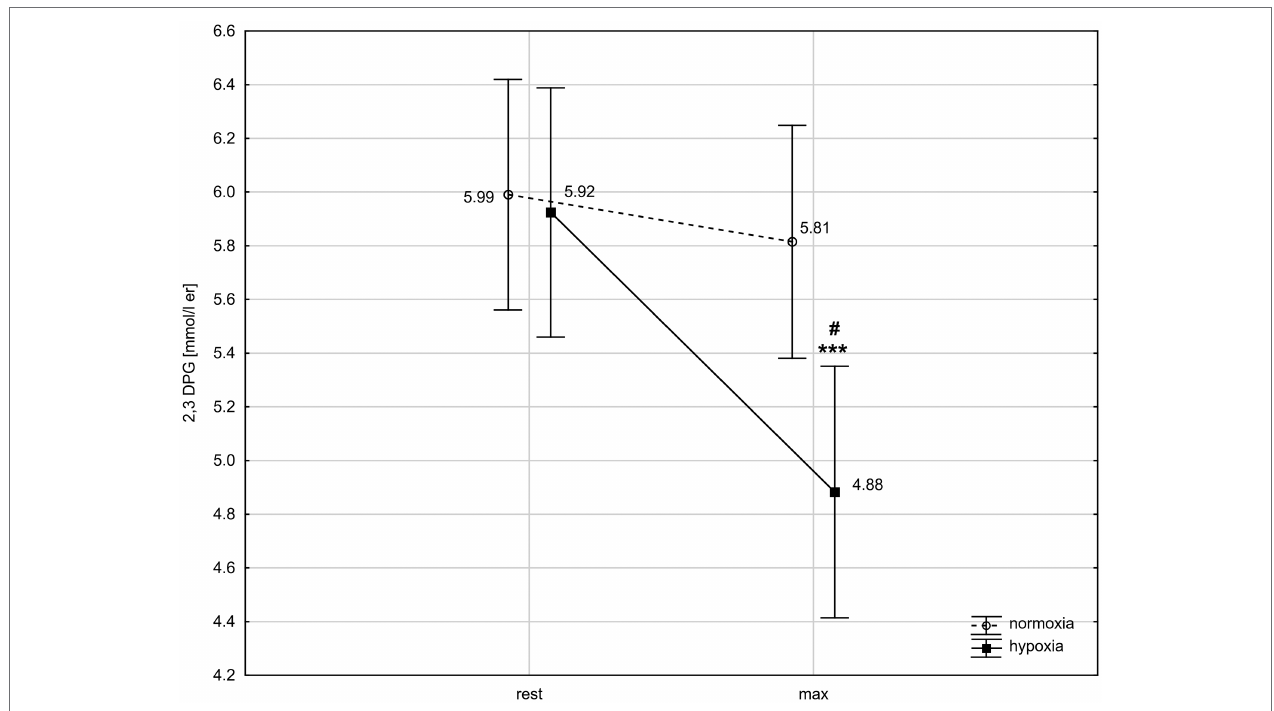
FIGURE 2 | 2,3-Diphosphoglycerate (2,3-DPG) levels in red blood cells before and after 30 km time trial in normoxia and hypoxia. All values shown as mean ± SD; rest – before time trial; max – immediately after time trial; *** p < 0.001 – significant difference between rest and max in the same conditions; # p < 0.05 – significant difference between N and H at the same measuring point.